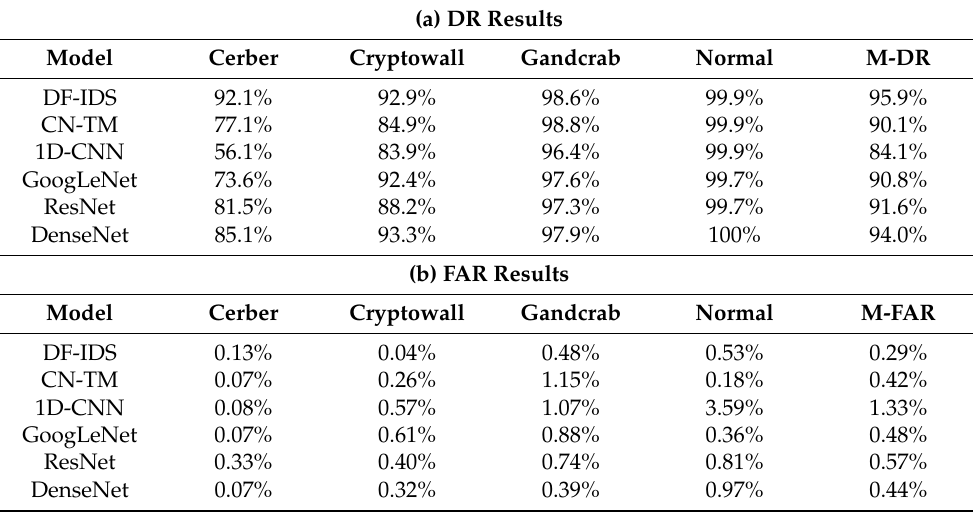
Table 11. Performance of multiclassification model using Dataset 2.